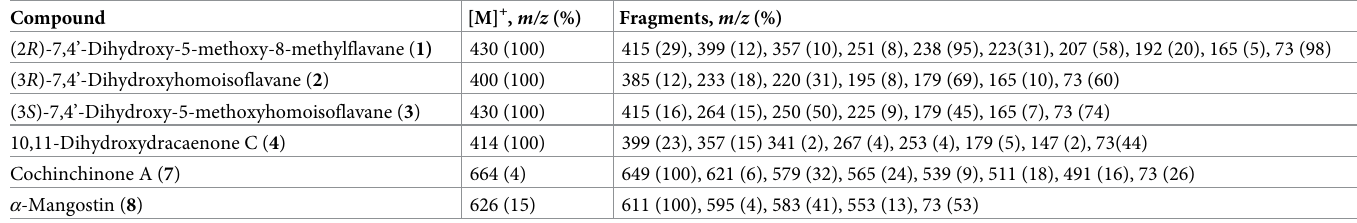
Table 2. Mass spectral data of isolated compounds (GC/MS, TMS